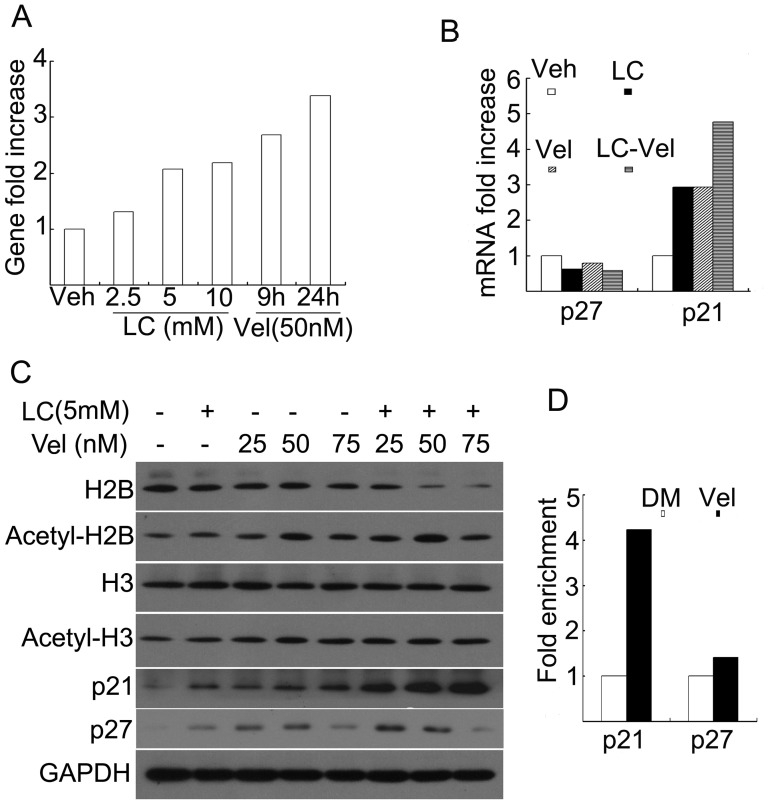
Vel and LC induces p21cip1 expression and histone expression.(A) p21cip1 gene expression. HepG2 cancer cells were either treated with various doses of LC (2.5, 5, 10 mM) for 24 h, or with 50 nM of Vel for 9 h and 24 h. A mixture of three cell samples were collected and DNA microarray assay was performed. Fold increase of the LC-treated versus control was shown. (B) p21cip1 mRNA expression. HepG2 cells were exposed to either LC (5 mM) and Vel (50 nM) or the combination for 18 h; a mixture of three cell samples were extracted for mRNA assay by real-time-PCR. Fold increases of p21cip1 and p27kip1 were shown. (C) p21cip1 protein expression and histone acetylation. HepG2 cells were treated with the combination of LC (5 mM) and various doses of Vel as indicated for 24 h, protein levels were detected by Western blot. Antibodies against p21cip1, p27kip1, histone and acetylated histones were used. GAPDH was used as a loading control. At least three repeats were performed and representative images were shown. (D) ChIP assay. HepG2 cells were treated with either vehicle or Vel (50 nM) for 24 h; cells were collected for ChIP assay. Fold enrichment of p21cip1 and p27kip1 promoter gene was summarized.